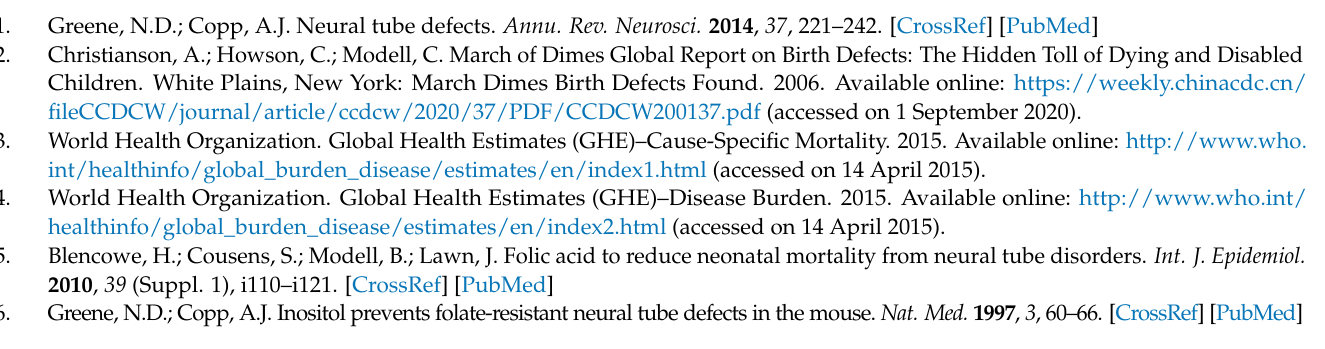
Table S7: Gene Ontology enrichment analysis of 226 mutual H3K27ac peak binding genes for BaP-NTD and BaP-nonNTD; Table S8: Gene Ontology enrichment analysis of 895 unique H3K27me3 peak binding genes for BaP-NTD; Table S9: Gene Ontology enrichment analysis of 431 unique H3K27ac peak binding genes for BaP-NTD; Table S10: Lists of H3K27me3 differential peaks between BaP-NTD and control group; Table S11: Lists of H3K27me3 differential peaks of BaP-nonNTD and control group; Table S12: Lists of H3K27ac differential peaks of BaP-NTD and control group; Table S13: Lists of H3K27ac differential peaks BaP-nonNTD and control group; Table S14: Lists of H3K27me3 differential peaks between BaP-NTD and BaP-nonNTD group; Table S15: Lists of H3K27ac differential peaks between BaP-NTD and BaP-nonNTD group; Table S16: Gene Ontology enrichment analysis of differentially H3K27me3 peak binding genes for BaP-NTD compared with BaP-nonNTD; Table S17: Gene Ontology enrichment analysis of differentially H3K27ac peak binding genes for BaP-NTD compared with BaP-nonNTD; Table S18: Descriptive summary of data generated by RNA-seq; Table S19: Lists of DEGs between BaP-NTD and controls; Table S20: Lists of DEGs between BaP-nonNTD and controls; Table S21: Lists of DEGs between BaP-NTD and BaP-nonNTD; Table S22: Lists of the overlaps of differential expressed genes and histone modified genes of BaP-NTD vs. control group; Table S23: Lists of the overlaps of differential expressed genes and histone modified genes of BaP-nonNTD vs. control group; Table S24: Lists of the overlaps of differential expressed genes and histone modified genes of BaP-NTD vs. BaP-nonNTD; Table S25: Results of motif enrichment by HOMER of BaP-NTD vs. control group; Table S26: Results of motif enrichment by HOMER of BaP-nonNTD vs. control group; Table S27: Results of motif enrichment by HOMER of BaP-NTD vs. BaP-nonNTD